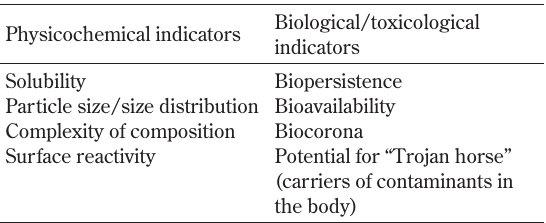
Table 4 Physicochemical and biological indicators to assess nanotoxicology (FAO/WHO,